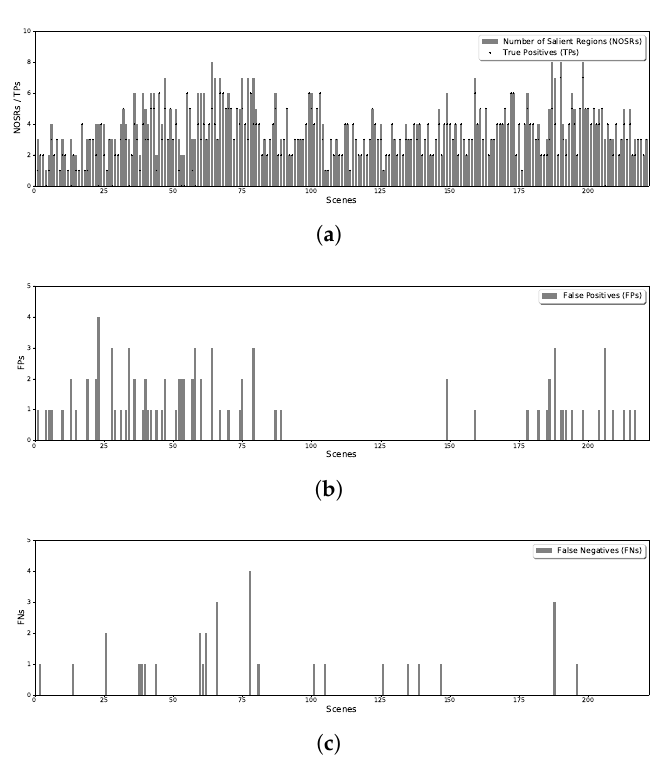
Figure 7. Statistical Results of Line Formation Case. ( a ) True Positives of Each Scene; ( b ) False Positives of Each Scene; ( c ) False Negatives of Each Scene.